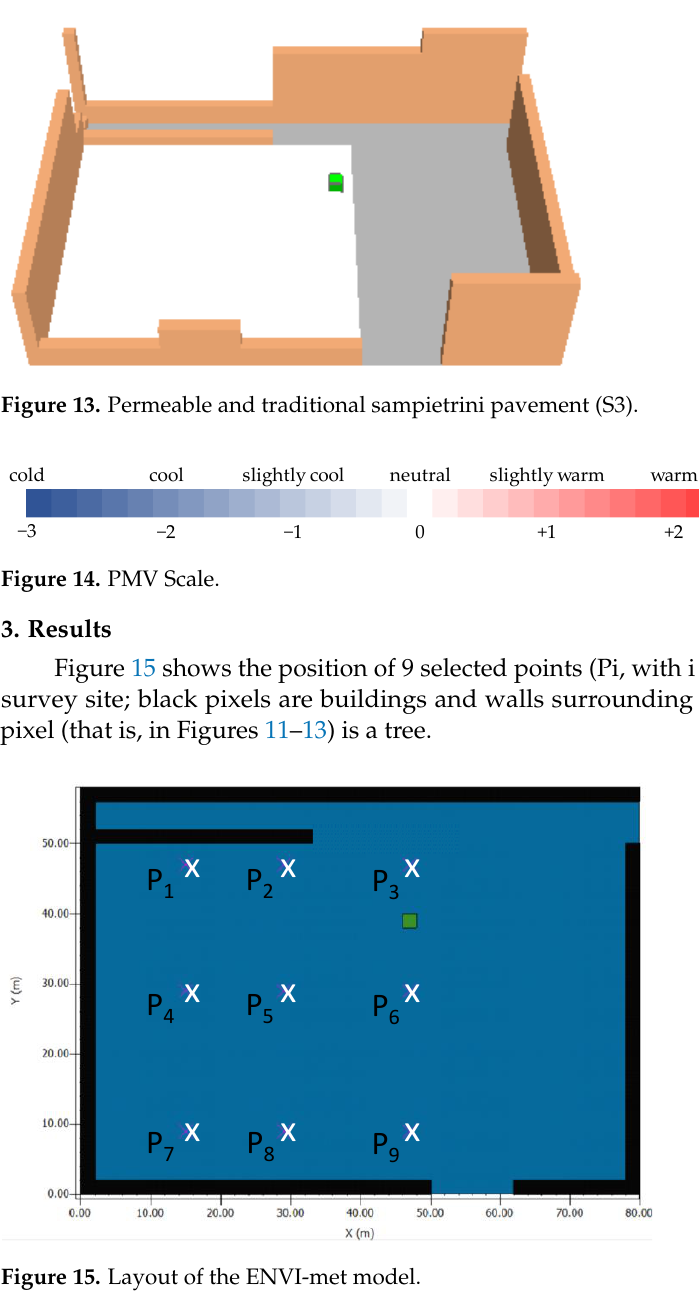
Figure 12. Traditional sampietrini pavement over all the square (S2).